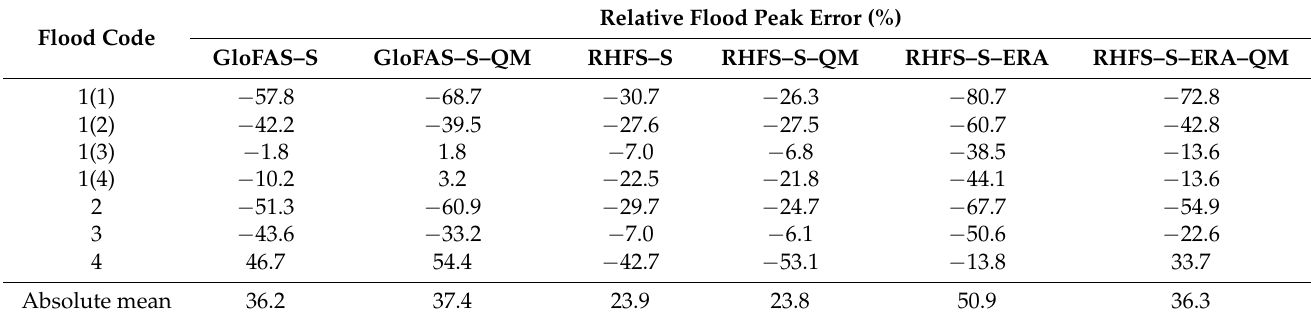
Table 2. Relative flood peak error of simulations for four flood events during the verification period. Relative Flood Peak Error Flood Code